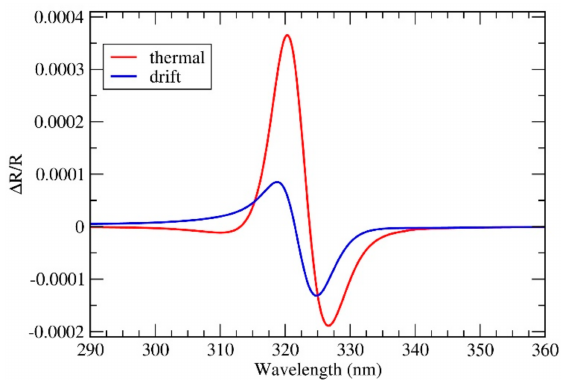
Figure 9. The calculated change in reflectivity for a 50 nm-thick Ag film on a quartz substrate for p-polarized light incident from the air side at an angle of incidence of 55 degrees. Results for (i) a thermal distribution with electron temperature change ∆ T e = 0.16 K (red line labelled thermal) and (ii) a rigid shift of the Fermi sphere (blue line labelled drift) with the same energy content as (i) are